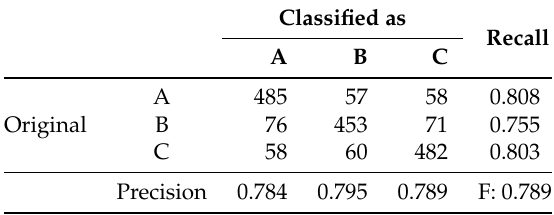
Table 6. Confusion matrix of linkage line visibility classification with